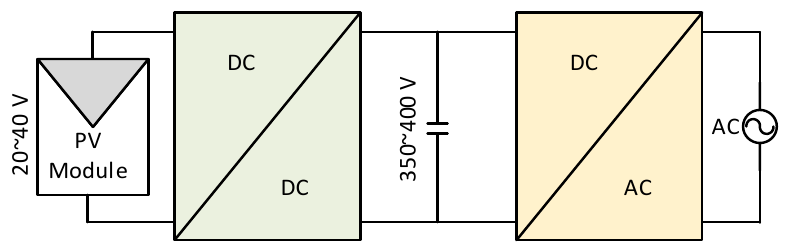
Figure 1. Two stage PV microinverter.